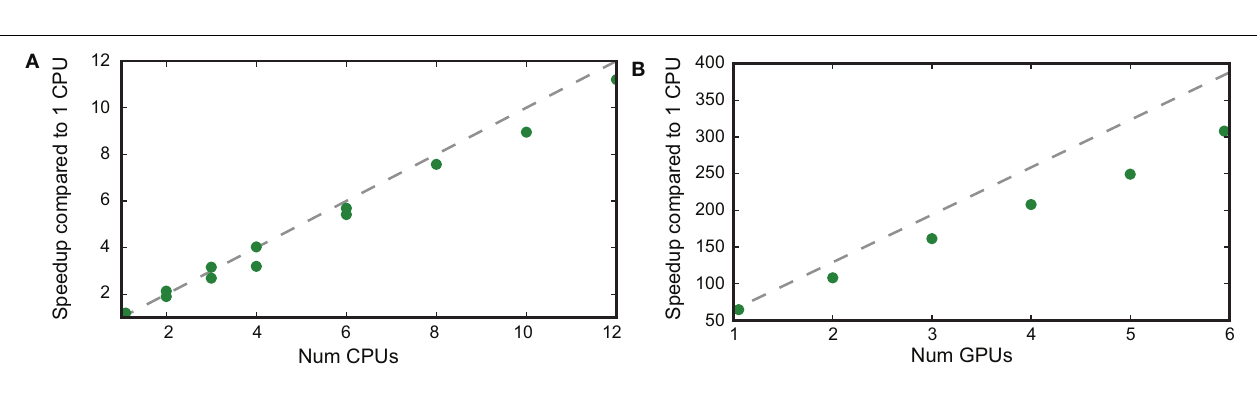
quad-core computers connected over a local Windows network. (B) Speedup in the simulation of 10 iterations with 2,000,000 particles as a function of the number of GPUs, relative to the performance of a single CPU (using the same number of particles). GPUs were spread on up to three PCs with dual-GPU cards (GTX